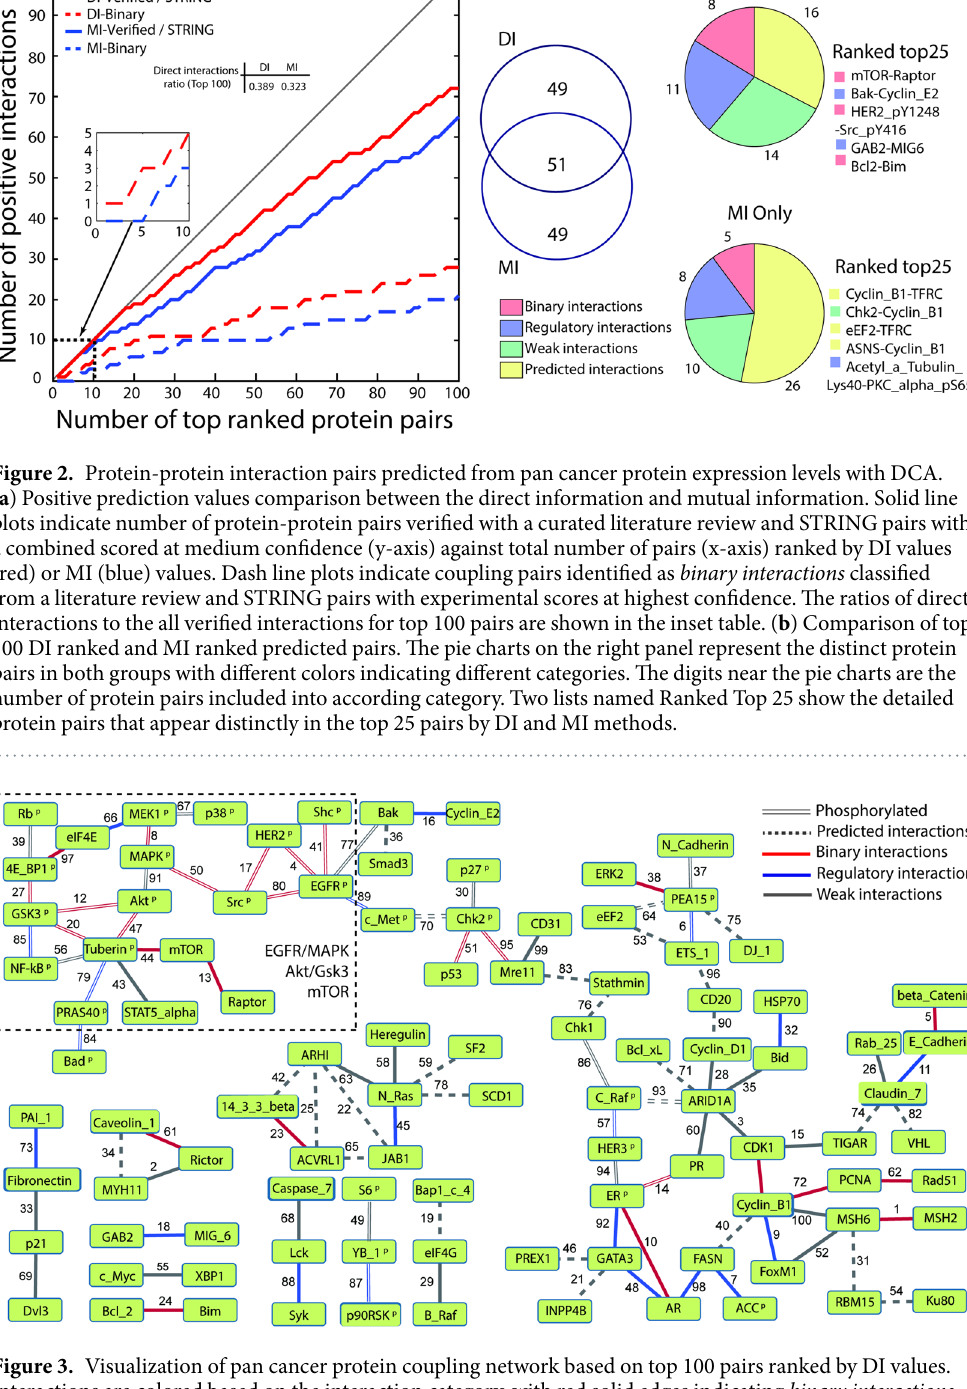
The EGFR/MAPK, Akt/Gsk3/mTOR pathway crosstalk is also recovered in this protein-coupling network. As shown in the network, Src acts as an intermediate between tyrosine kinase receptors, EGFR and HER2, and MAPK pathway 34 . The network also contains the regulatory interactions between eIF4E and MEK1, known as the MEK/ERK/Mnk1/eIF4E signaling pathway 35 . The interactions between Akt and other proteins is also revealed